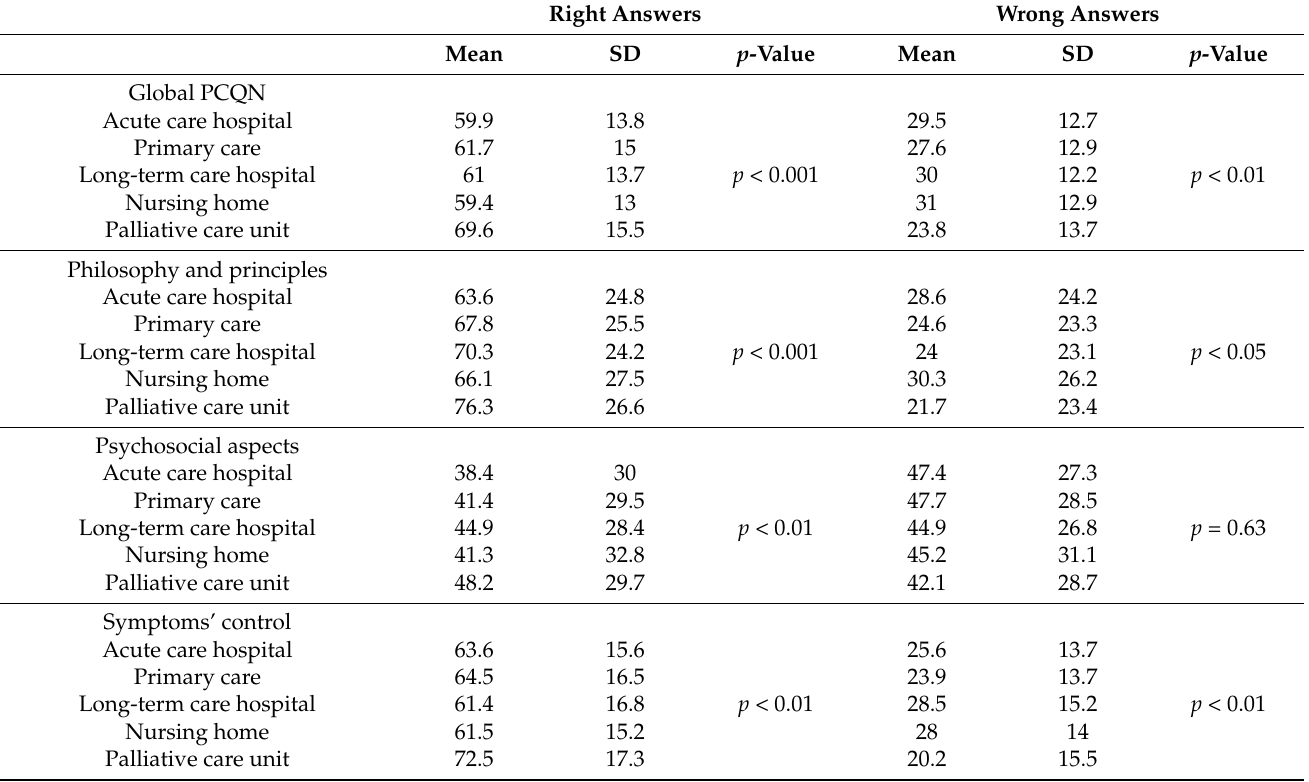
Table 6. Differences in results obtained in PCQN-SV according to the health setting where the participants worked. Right Answers Wrong Answers Mean SD p -Value Mean SD p -Value Global PCQN